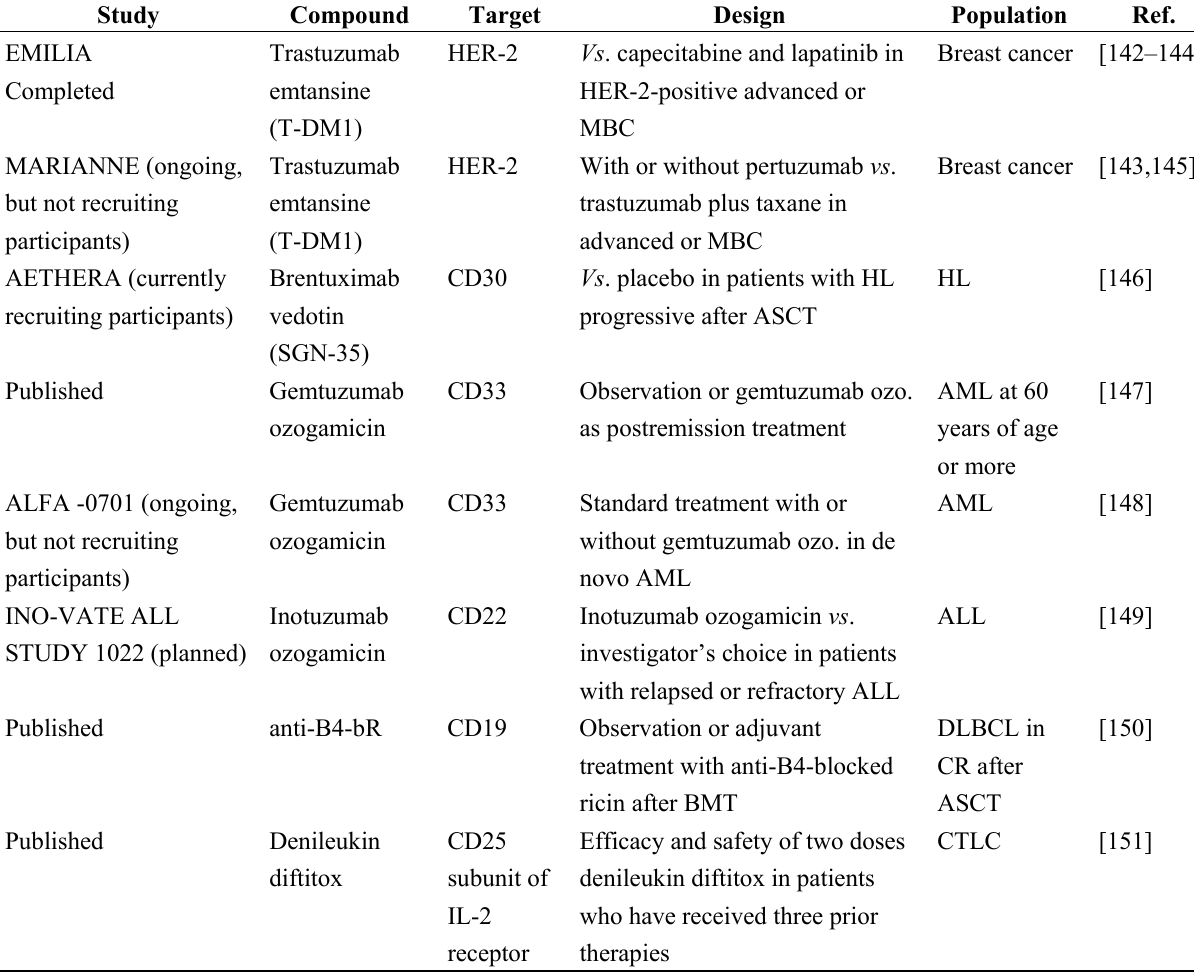
Table 3. Active, planned and ongoing phase III trials of the most developed